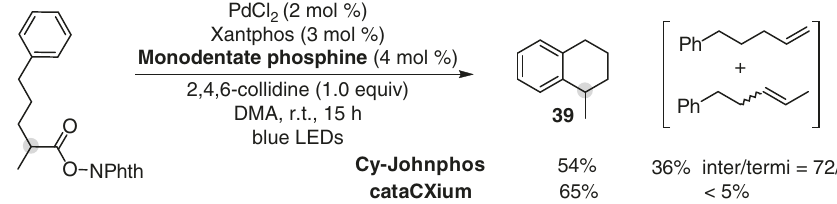
Fig. 5 Reaction selectivity study. Cyclization/elimination selectivity induced by monodentate phosphine ligands